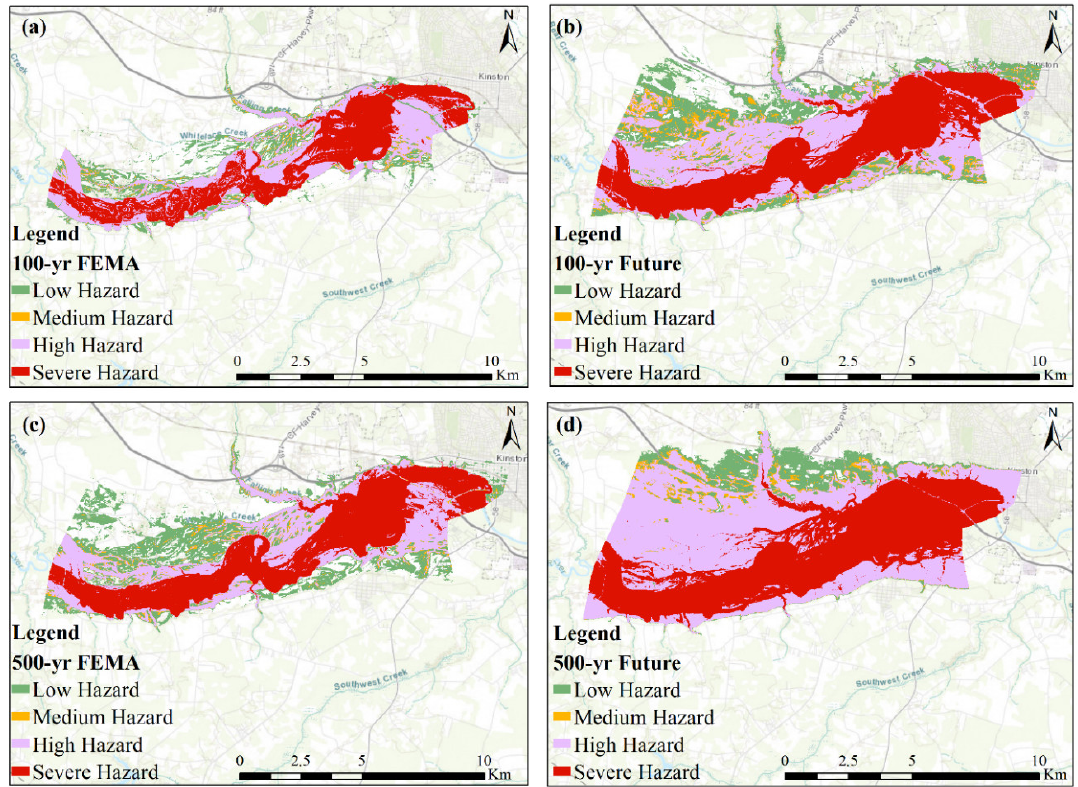
Figure 8. A Comparison of extent of flood hazard utilizing different flooding scenarios, i.e., FEMA and Future, respectively, for ( a , b ) 100 and ( c , d ) 500-year return period flood events. Source: Esri, HERE, Garmin, Intermap, increment P Crop., GEBCO, USGS, FAO, NPS, NRCAN, GeoBase, IGN, Kadaster NL, Ordnance Survey, Esri Japan, METI, Esri China (Hong Kong), swisstopo © OpenStreetMaps contributors, and the GIS User